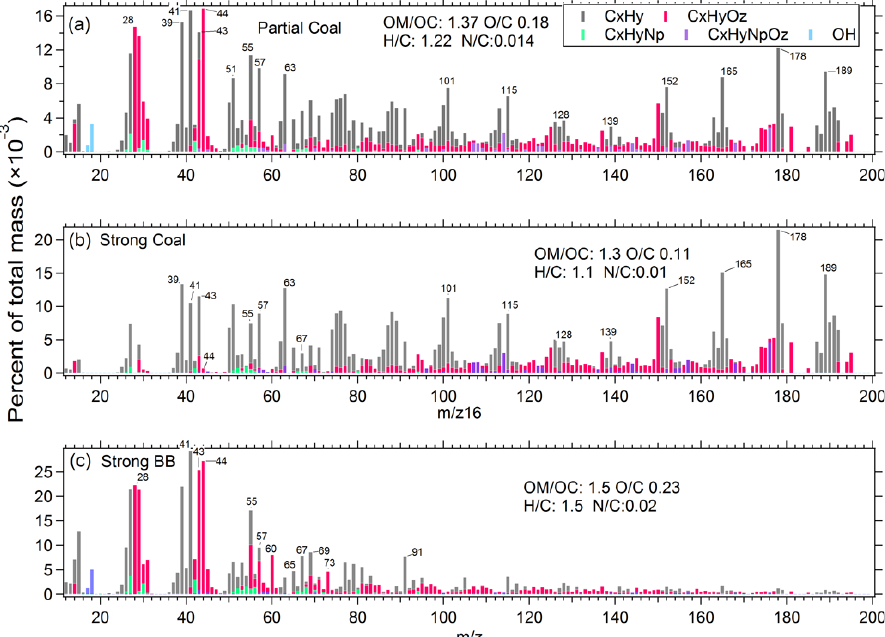
Fig. 4. High resolution mass spectra of OA in the plumes that are (a) partially-influenced by coal combustion, (b) strongly-influenced by coal combustion, (c) influenced by biomass burning emissions. The intensity of coal combustion influence is based on gas-phase naphthalene concentrations. The elemental ratios and OM/OC ratios are also shown in the legends.